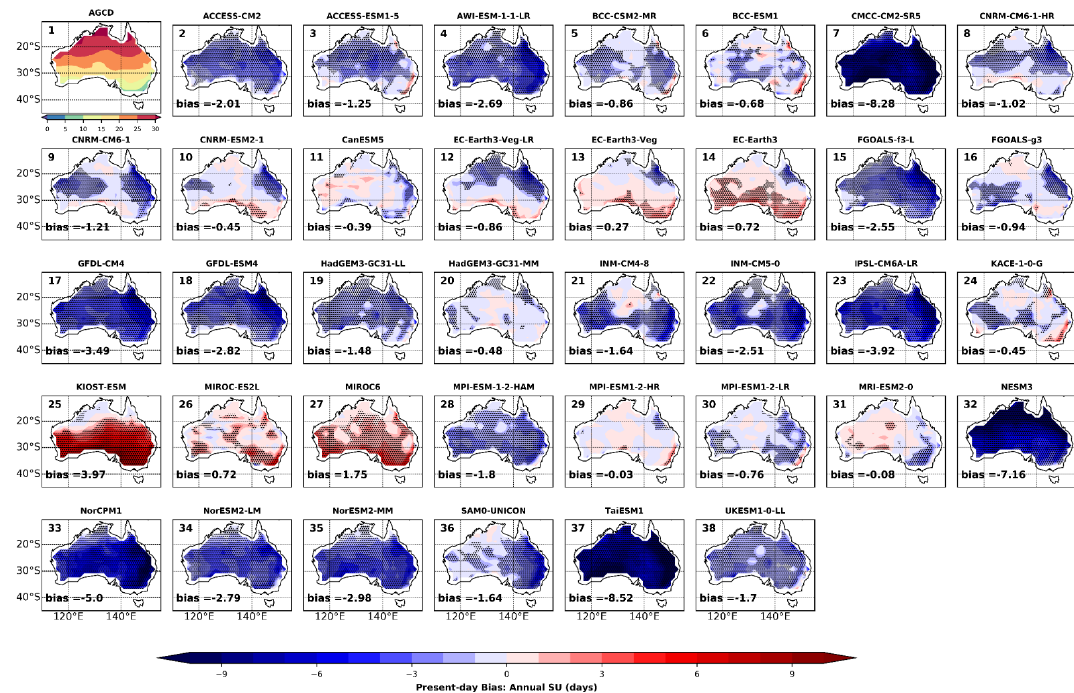
Figure 8. Climatological mean annual bias in summer days (number of days when maximum temperature > 25 ◦ C) (SU: days) relative to the Australian Gridded Climate Data dataset (AGCD; panel 1 ) for the individual CMIP6 GCMs (panels 2 – 38 ). Data spans 1951–2014. Stippling indicates statistically significant differences using a student’s t -test at the 95% confidence level.